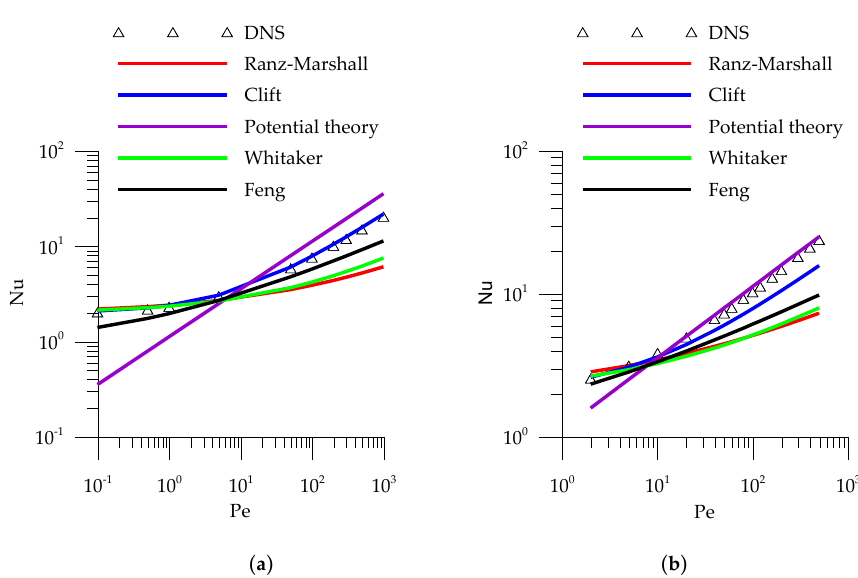
Figure 6. Applicability of correlations for predicting the average Nusselt number of clean spherical bubbles (DNS data from [63]): ( a ) Re p = 0.1, Pr = 1 ∼ 10 4 . ( b ) Re p = 1 ∼ 250, Pr l = 2. DNS: Direct Numerical